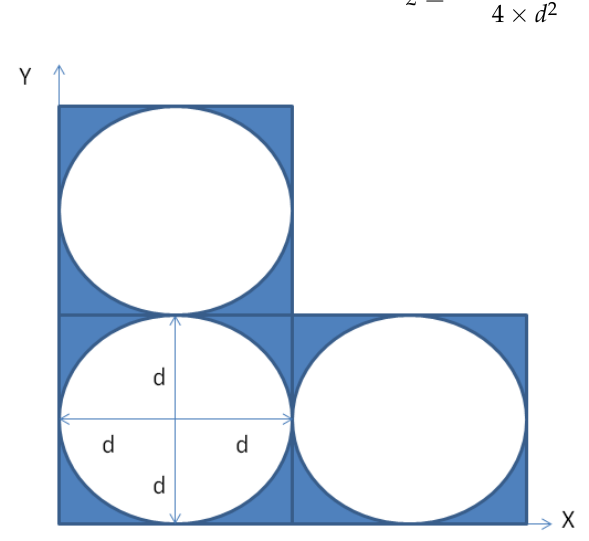
Figure 2. Square approximation of circular coverage.